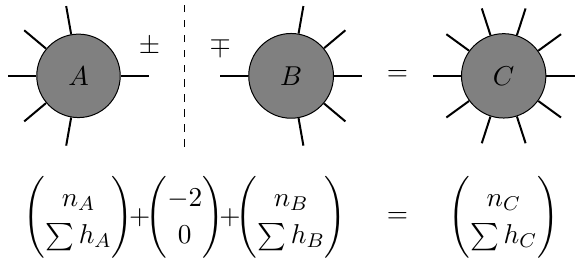
Figure 3 . The tree-level rule for constructing amplitudes in ( n; P h ) space